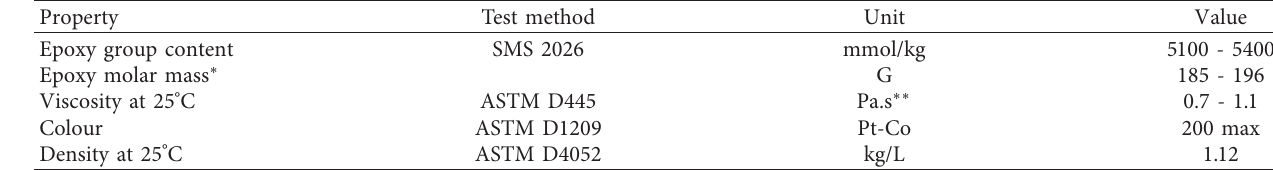
Table 1: Properties of epoxy Epikote 240 resin.